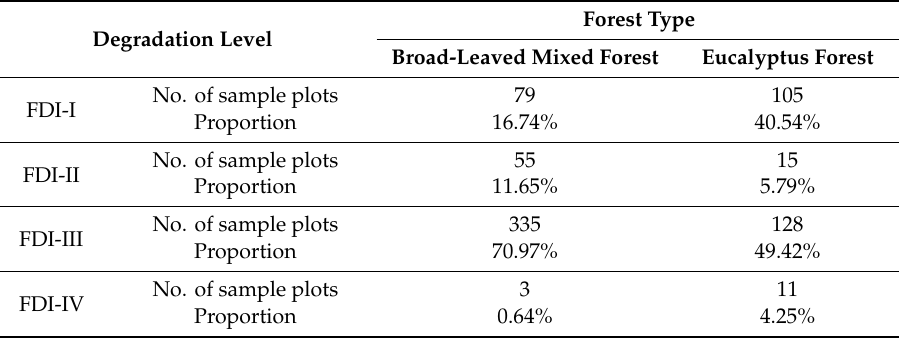
Table 5. Evaluation results of forest degradation grade of two forest types divided by dominant tree species in the Guangdong province. A total of 731 sample plots of the province were included in the study. FDI: forest degradation